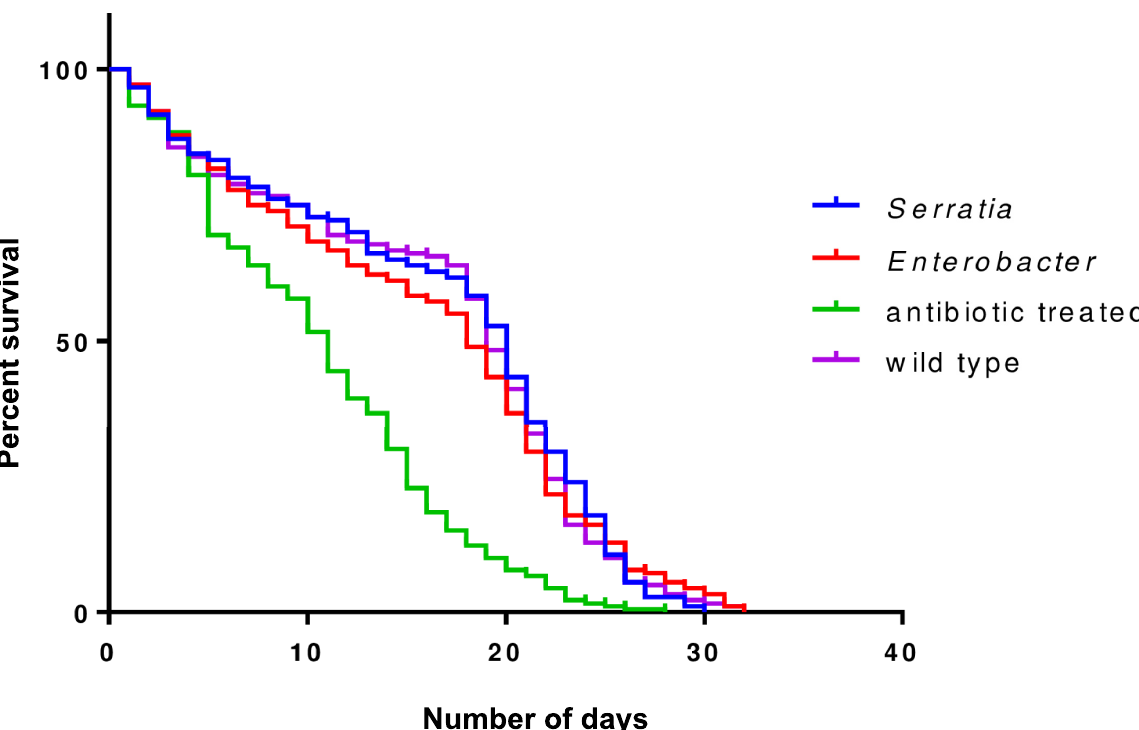
Fig 1. Survival analysis of An . gambiae s.l. following antibiotic treatment and bacteria reintroduction. The group, antibiotic-treated are antibiotic-treated with no bacteria reintroduction and wild type are non-antibiotic-treated.